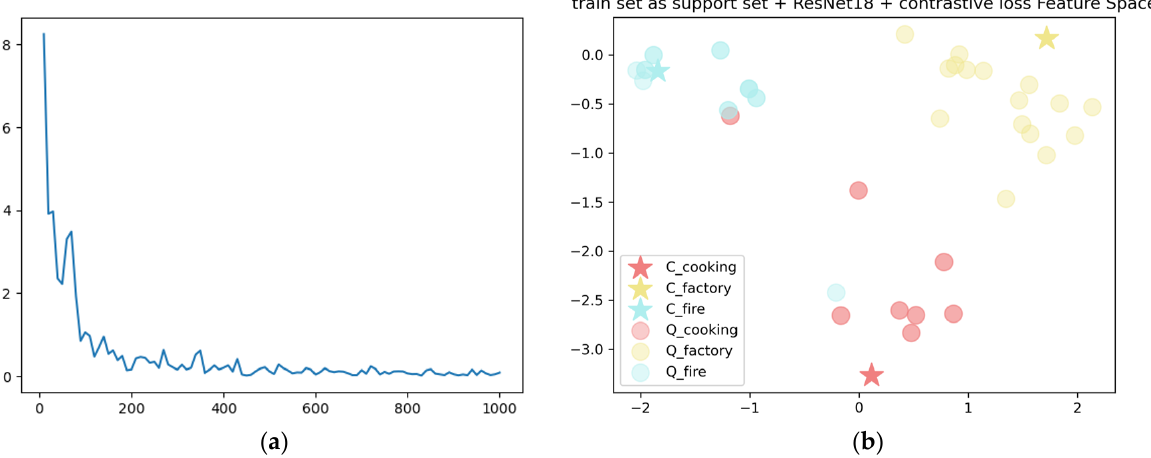
Figure 8. ( a ) Network training curve, and ( b ) distribution of feature vectors of test samples in feature space.